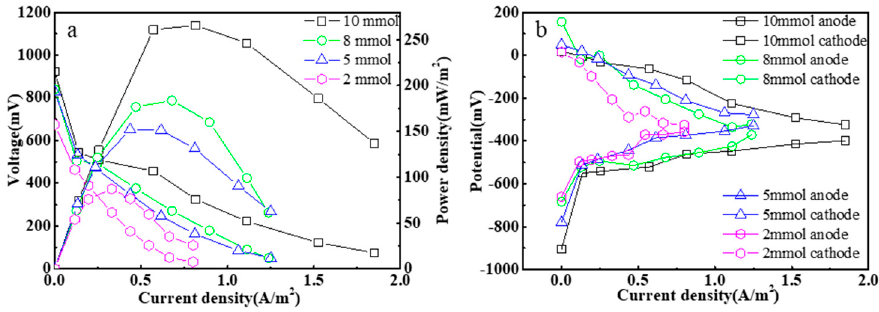
Figure 3. ( a ) Power density and polarization curves and ( b ) electrode potential curves for the alu- aluminum − air fuel cell with different electrolyte minum − air fuel cell with different electrolyte concentrations.